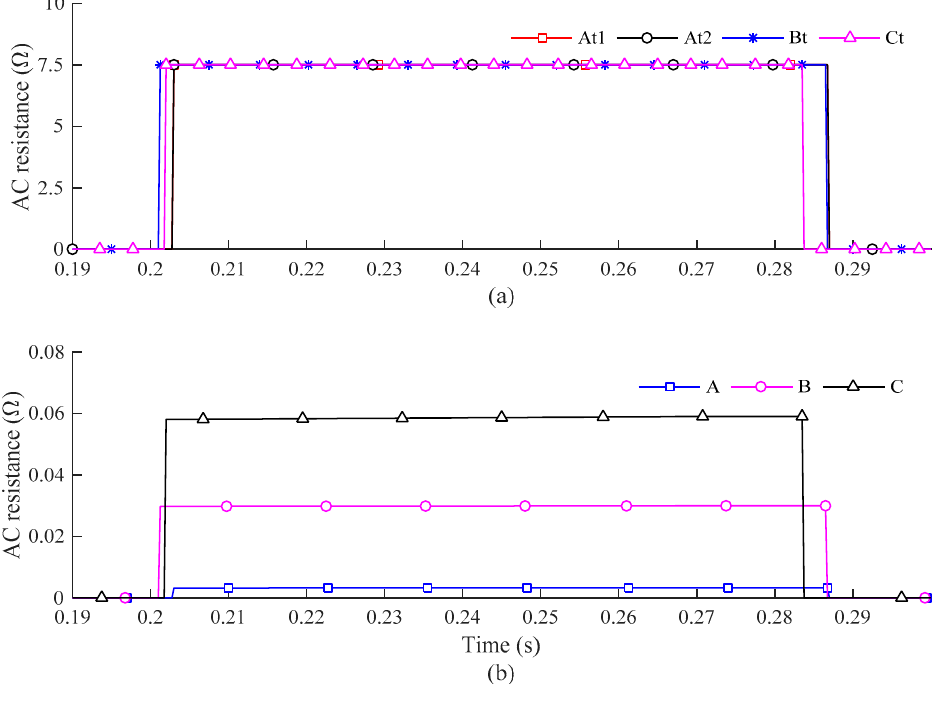
Figure 12. AC resistances of the HTS tape layers and the equivalent resistance of each phase: ( a ) resistance of the HTS tape layers; and ( b ) equivalent resistance of each phase.